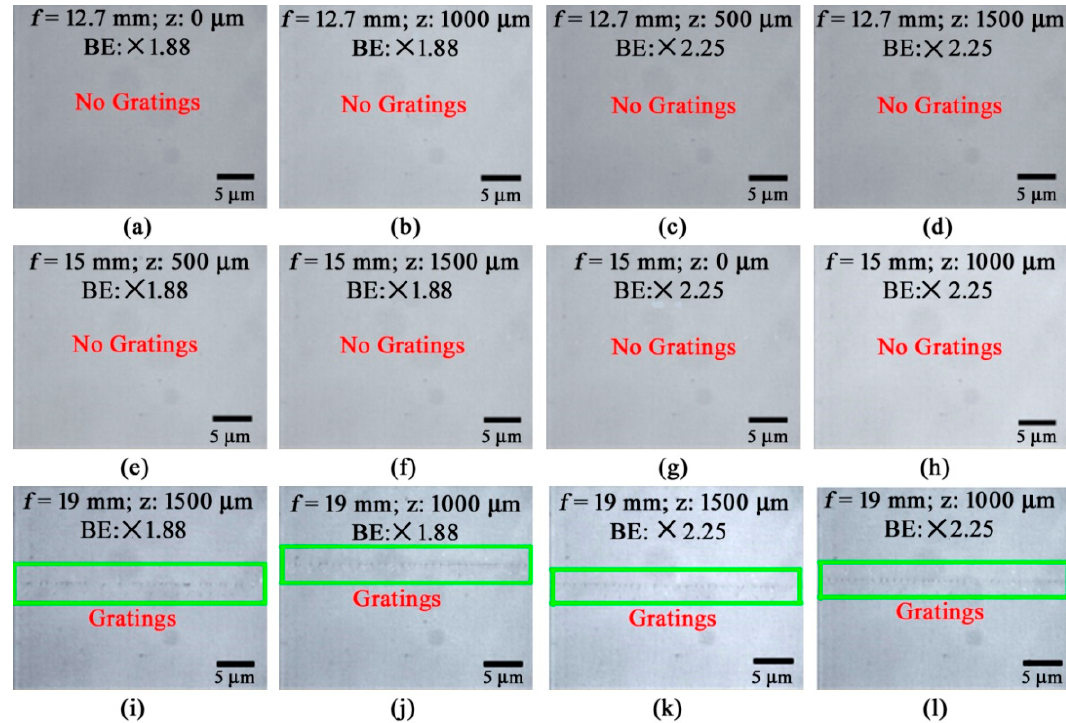
Figure 4. Formation of Bragg gratings inside fused silica glass for optimization of irradiation conditions of the femtosecond laser beam. ( a – d ) Using a cylindrical lens with f = 12.7 mm: ( a ) P: 817 mW, z : 0 μ m, BE: ×1.88; ( b ) P: 817 mW, z : 1000 μ m, BE: ×1.88; ( c ) P: 610 mW, z : 500 μ m, BE: ×2.25; ( d ) P: 610 mW, z : 1500 μ m, BE: ×2.25; ( e – h ) using a cylindrical lens with f = 15 mm: ( e ) P: 787 mW, z : 500 μ m, BE: ×1.88; ( f ) P: 787 mW, z : 1500 μ m, BE: ×1.88; ( g ) P: 805 mW, z : 0 μ m, BE: ×2.25; ( h ) P: 805 mW, z : 1000 μ m, BE: ×2.25; ( i – l ) using a cylindrical lens with f = 19 mm: ( i ) P: 787 mW, z : 1500 μ m, BE: ×1.88; ( j ) P: 787 mW, z : 1000 μ m, BE: ×1.88; ( k ) P: 600 mW, z : 1500 μ m, BE: ×2.25; ( l ) P: 600 mW, z : 1000 μ m, BE: ×2.25.